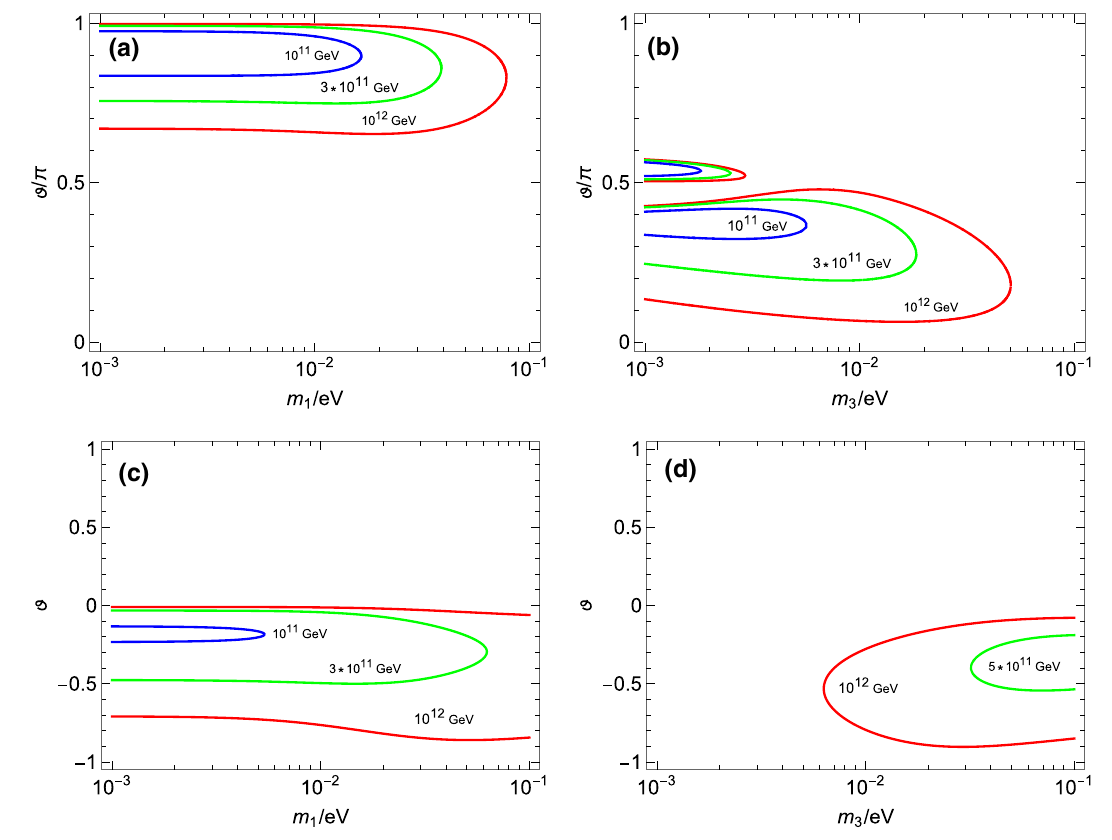
= 1 ( a ); the IO case with 2 = − 1 ( c ); the IO case with η = − 2 2